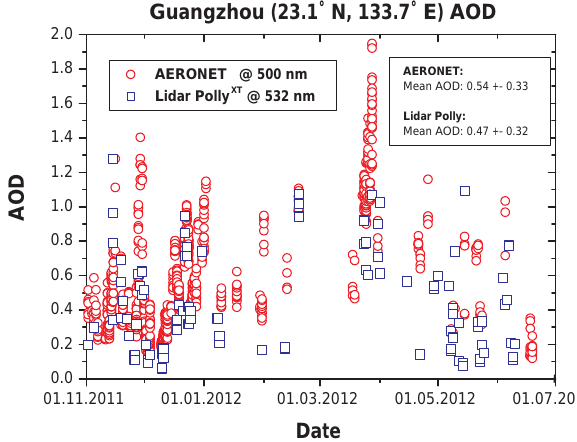
Figure 1. AOD derived from Polly XT Raman extinction measure- ments at 532nm and AERONET level 2 AOD derived from sun photometer measurements at